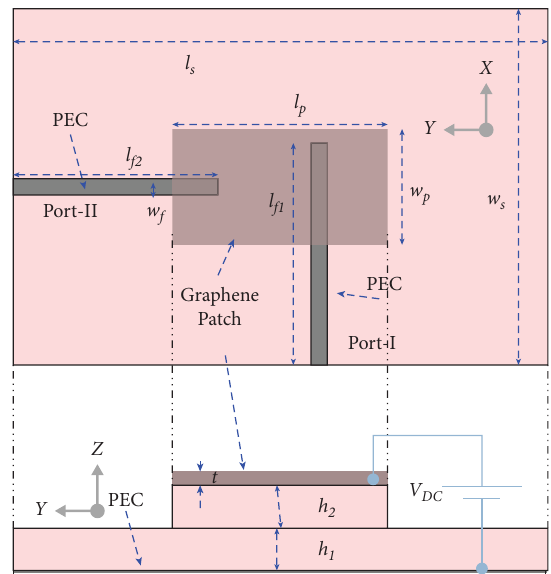
Figure 2: Confguration of the proposed graphene-based full- duplex